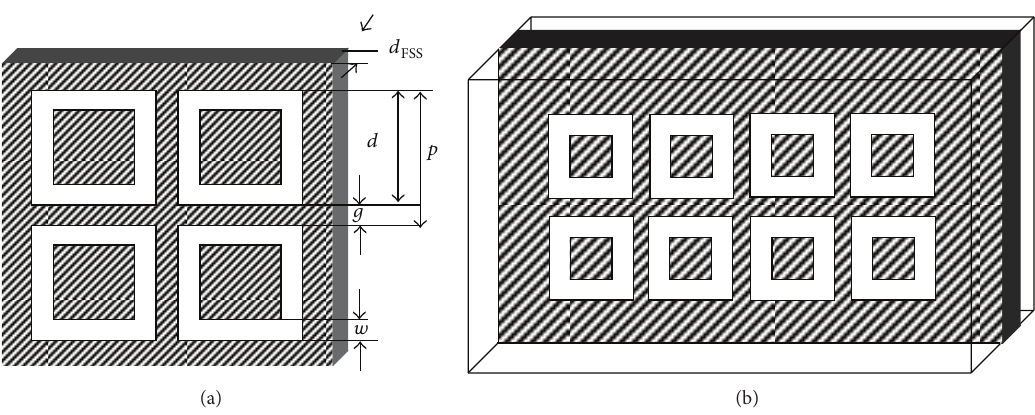
Figure 1: (a) Schematic of the single square loop (SSL)-FSS and (b) Monolithic slab of half-wave thickness. SSL-FSS is centrally loaded w . r . t . : thickness of SSL-FSS; 𝑔 : gap length; 𝑑 : length of SSL element; and 𝑤 : width of SSL element. the midplane. Here 𝑝 : periodicity; 𝑑 FSS